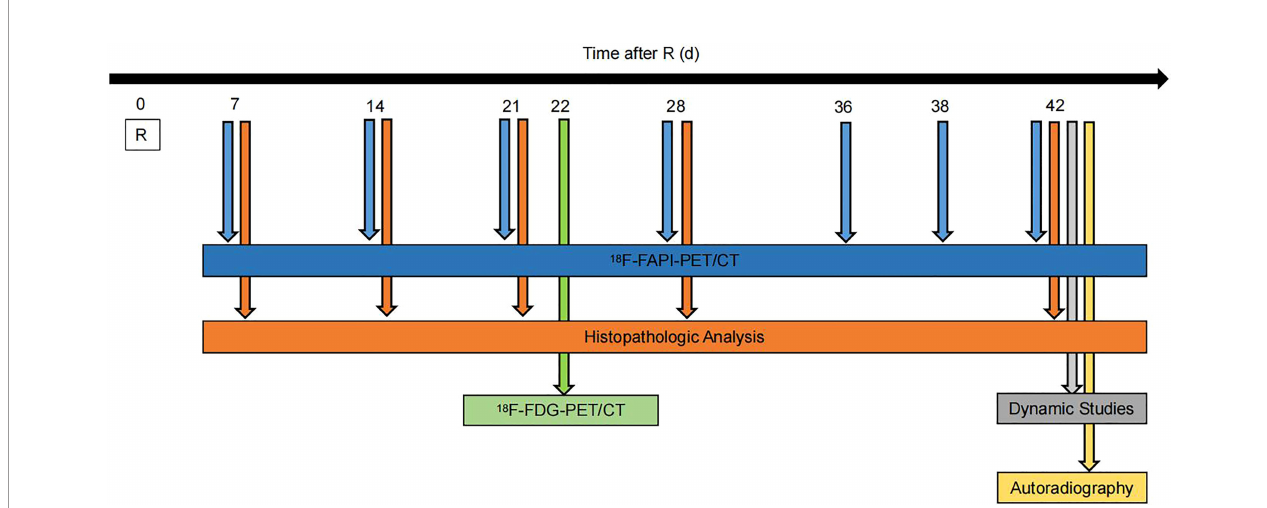
FIGURE 1 | Experimental timeline. Wistar rats were given 90Gy radiation on day 0. Static 18 F-NOTA-FAPI PET/CT scans were performed at 7, 14, 21, 28, 36, 38 and 42 days after radiation, dynamic 18 F-NOTA-FAPI-PET/CT scans were performed at 42 days after radiation, and static 18 F-FDG-PET/CT scans were performed at 22 days after radiation. Autoradiography (n = 3) was performed at 42 days after radiation, and pathological examination was performed at 7, 14, 21, 28 and 42 days after